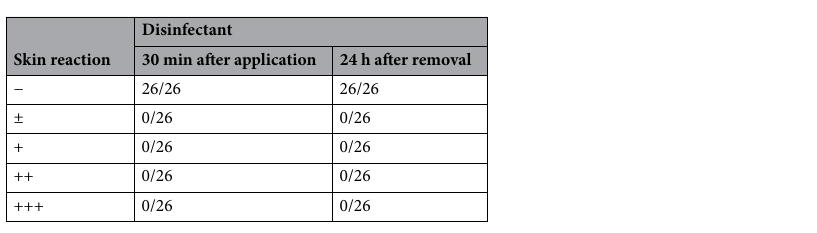
Table 3. Skin reaction in the human patch test.